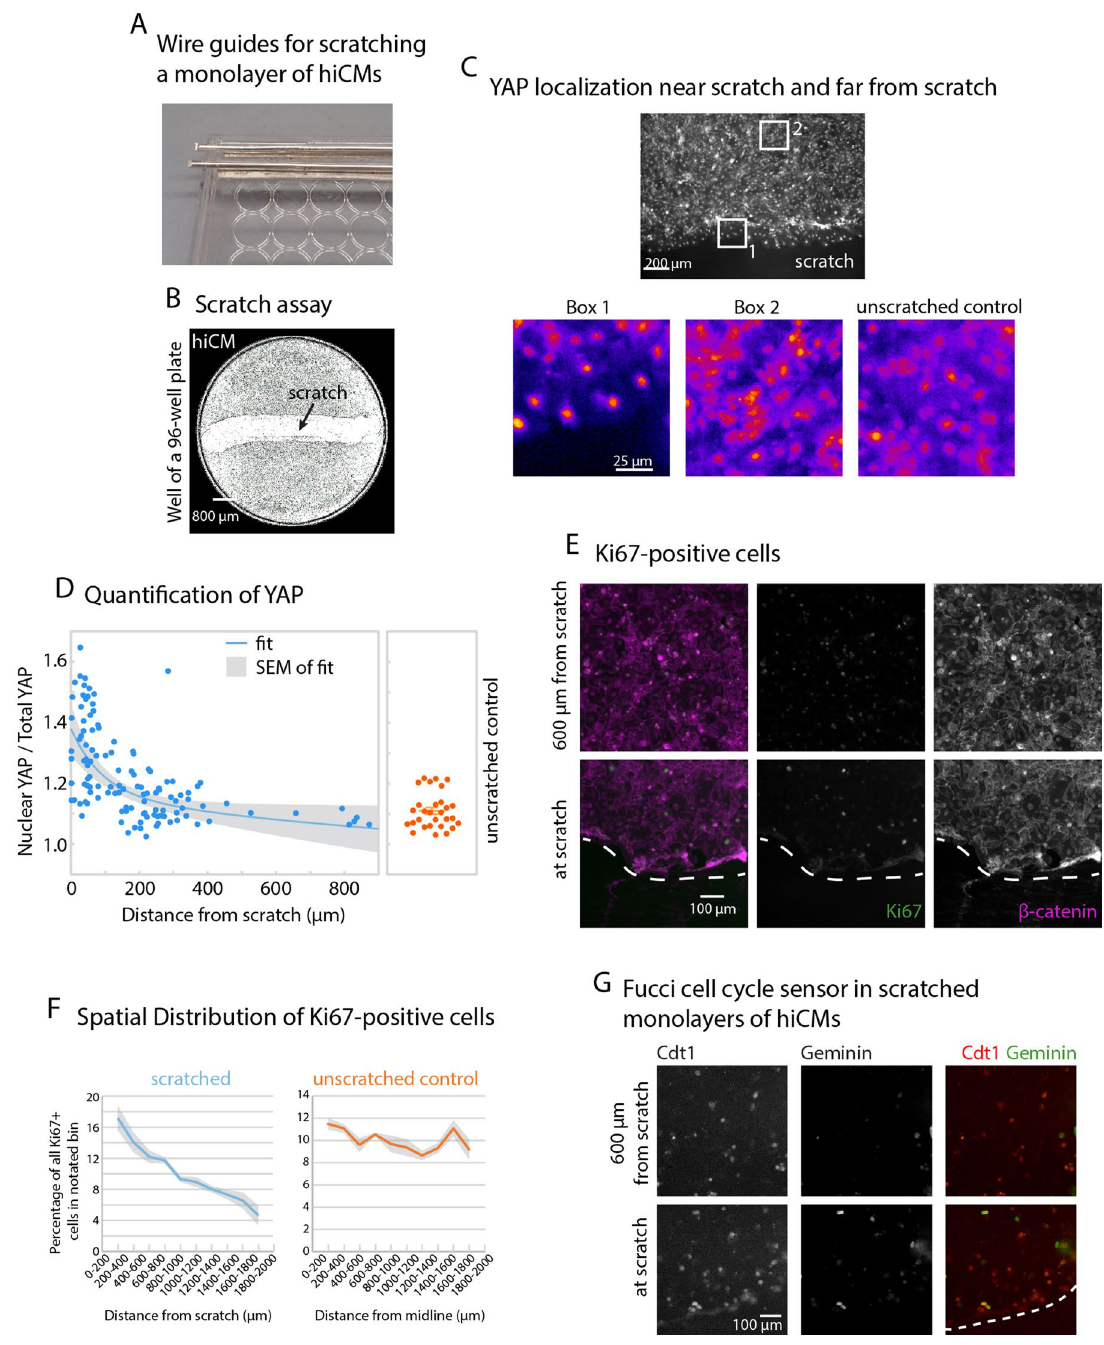
Figure 1. Reducing hiCM density by a scratch assay increases proliferative capacity. ( A ) Wire guide for scratching a monolayer of hiCMs, using a lid of a 96-well plate and a Dremel tool to drill through the plastic lid. Wire guides are composed of a bottom layer of flattened 21-gauge wire glued to the lid and a top layer of cylindrical wire to guide the pipette tip. ( B ) 4 × whole-well phase-contrast image of hiCMs in a well of a 96-well plate, 48 h post-scratch. ( C ) YAP immunolocalization near the scratch (box 1) and far from the scratched (box 2) using 20 × widefield microscopy. ( D ) Quantification of Nuclear YAP divided by total YAP (n = 79 cells from 5 independent experiments). Unscratched control (n = 29 cells from 3 independent experiments). ( E ) Ki67 and β-catenin in a scratched plate 48 h post-scratch using 20 ×. ( F ) Spatial distribution of Ki67-positive hiCMs in a scratched well or in an unscratched control well 48 h post-scratch. ***p < 0.0001, Chi-square = 80.434 with a two by five contingency table comparing distributions of Ki67 in different regions within 2 mm of the scratch or center of the midline of the well. ( G ) Fucci cell cycle probe transduced into a monolayer of hiCMs and scratched or not